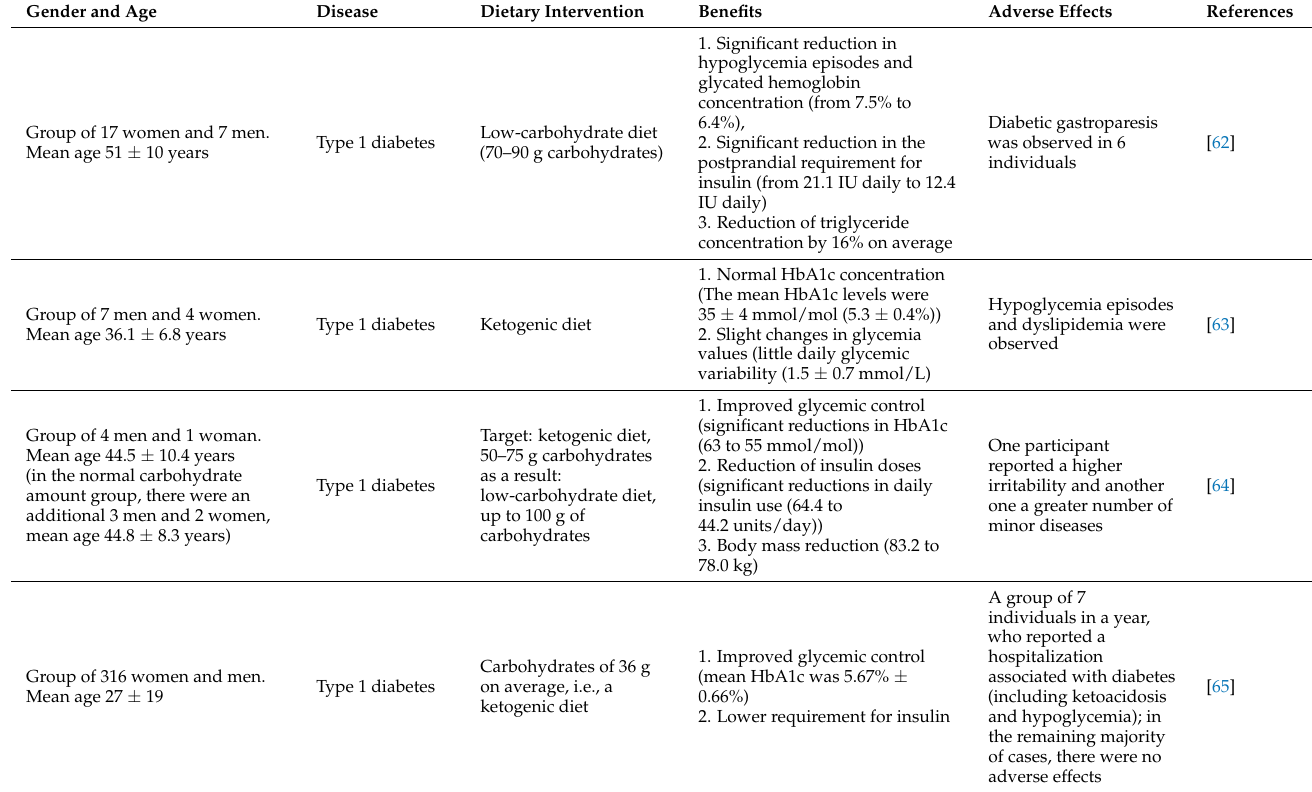
Table 2. Effect of a ketogenic diet in adults with type 1